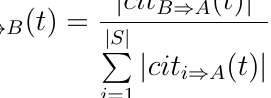
Algorithm 1 Method for calculating Citation Ratio value CR ( computeCR ) with consideration of